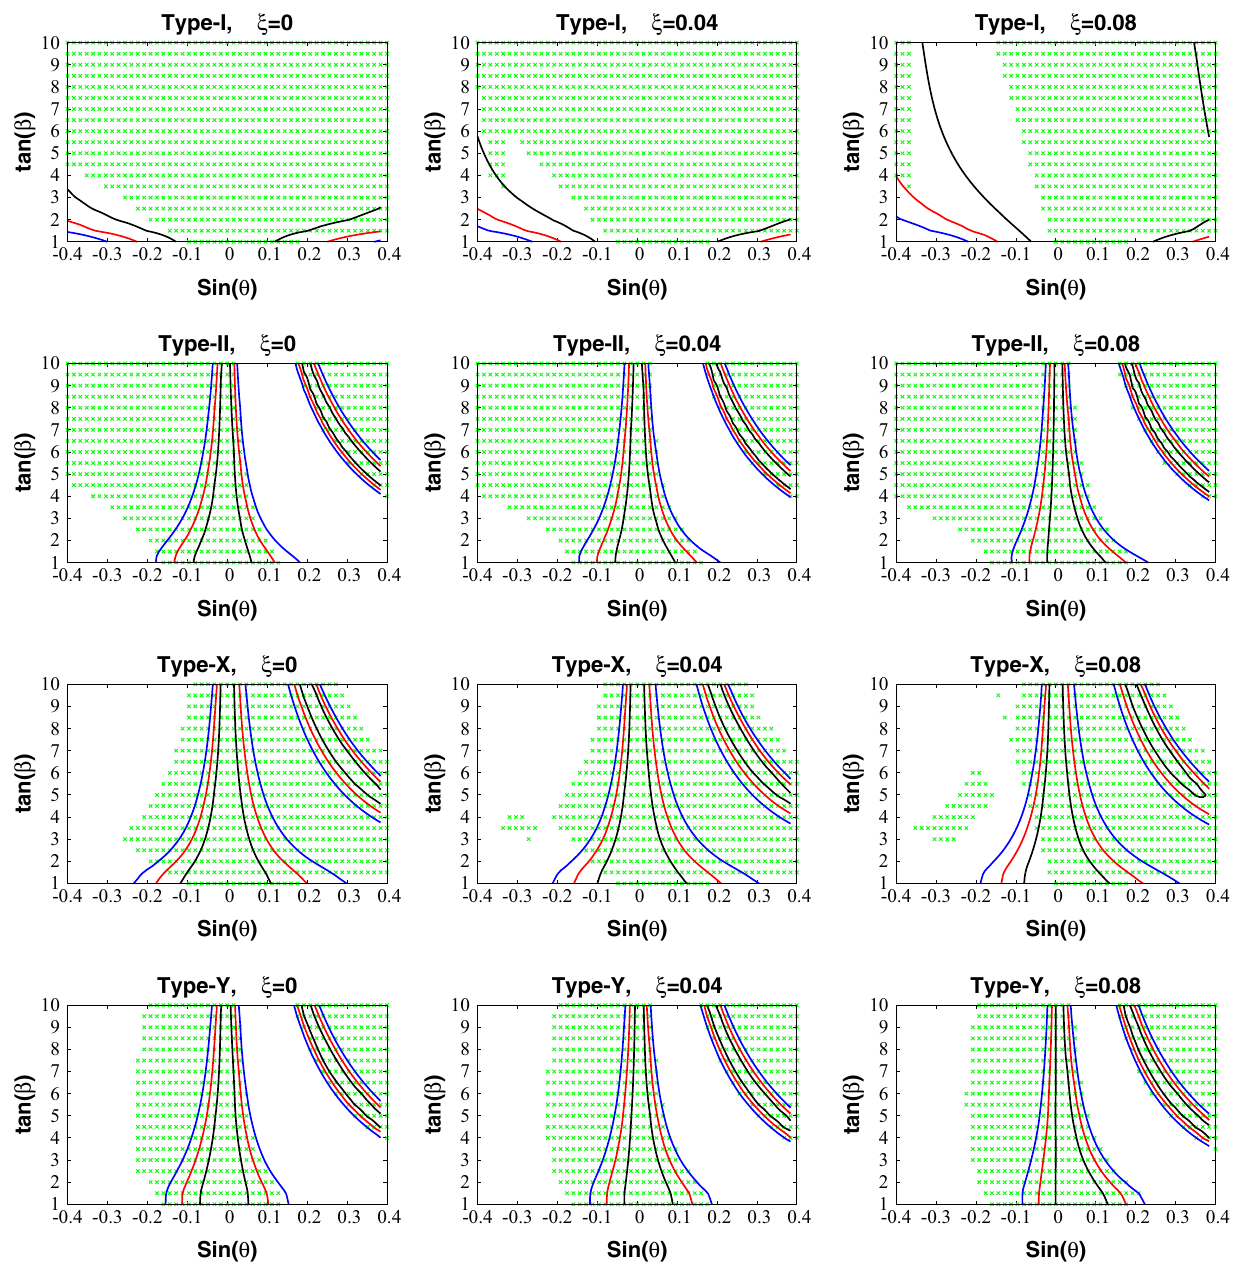
Fig. 1 Regions allowed at 95% CL from LEP, Tevatron and LHC experiments in the Type-I, -II, -X and -Y C2HDMs ( green shaded ). The black , red and blue curves display the contours for (cid:18)χ 2 = 2 . 30 (68.27% CL), 6.18 (95.45% CL) and 11.83 (99.73% CL), respec-